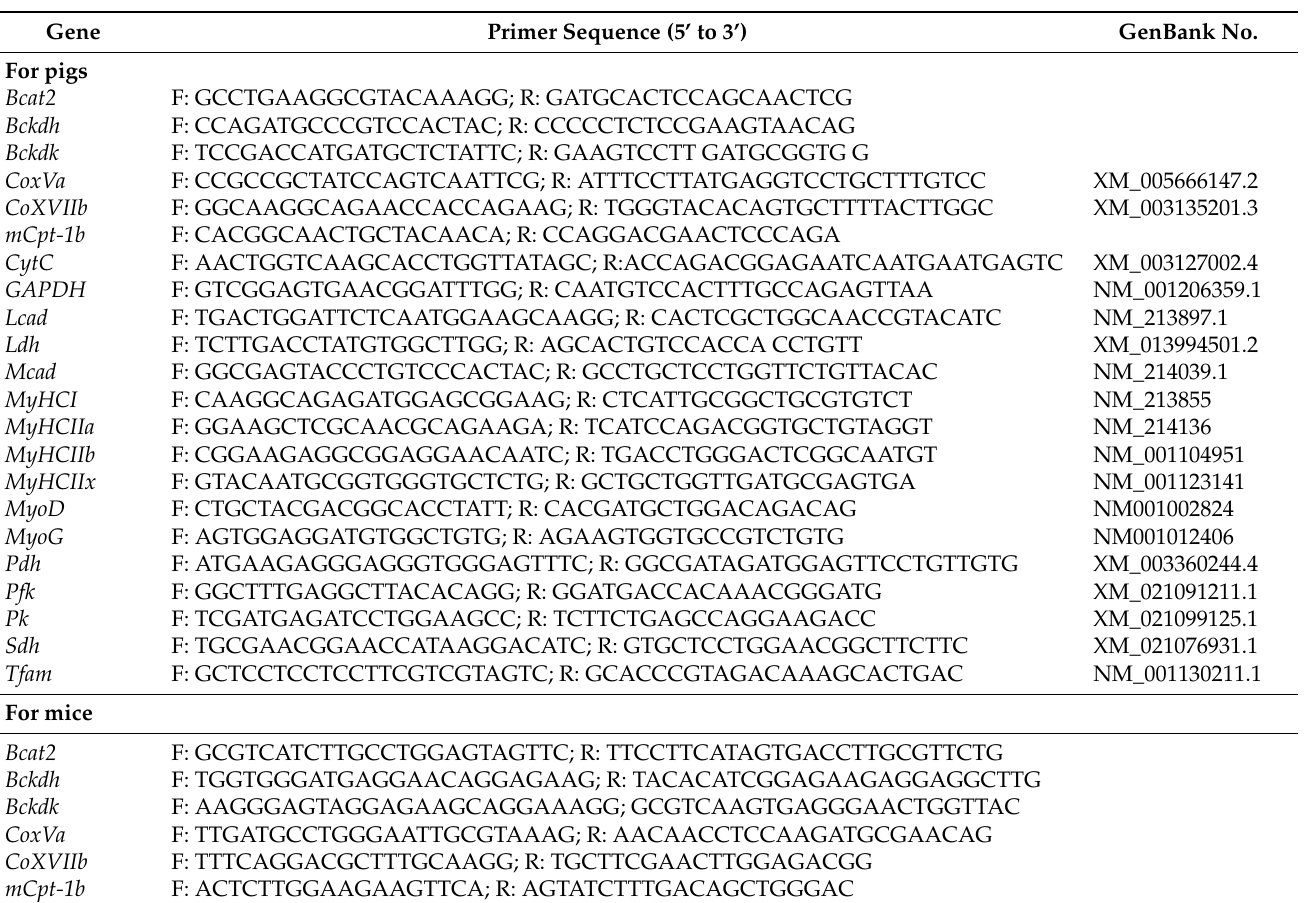
Table 1. Primer sequences used for